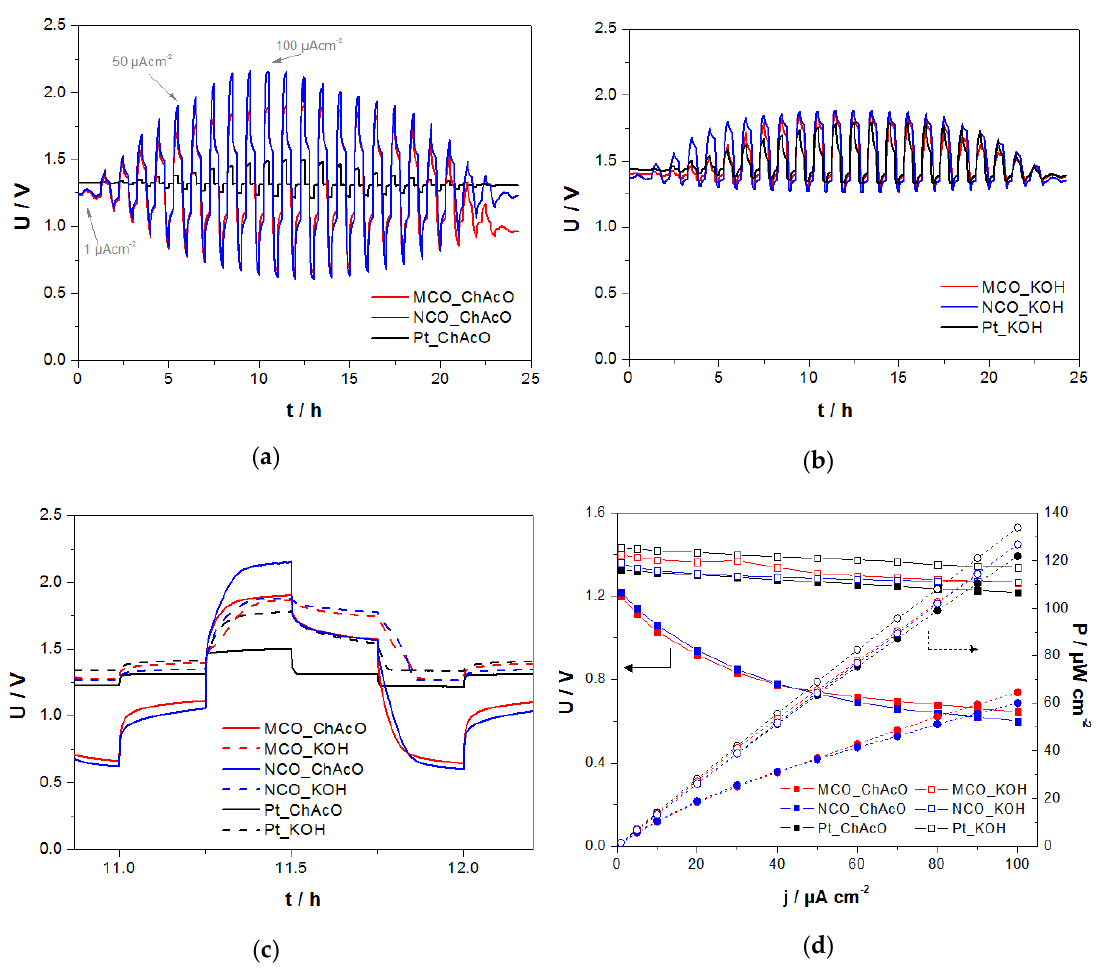
Figure 11. U/I curves of different Zn/air cells between 1 and 100 µA cm − 2 for 1 h per cycle (15 min charge/discharge each) with dry air in ( a ) 30 wt.% ChAcO + 0.01 M ZnAcO and ( b ) 7 M KOH solutions. ( c ) Selection of a single cycle at 100 µA cm − 2 in (solid lines) choline acetate and (dotted lines) KOH. ( d ) Comparison of polarization (solid lines) and power density (dotted lines) behavior during the discharge protocol in ChAoC from Figure 11a and KOH from Figure 11b at current increment from 1 to 100 µA cm − 2 in the forward direction.